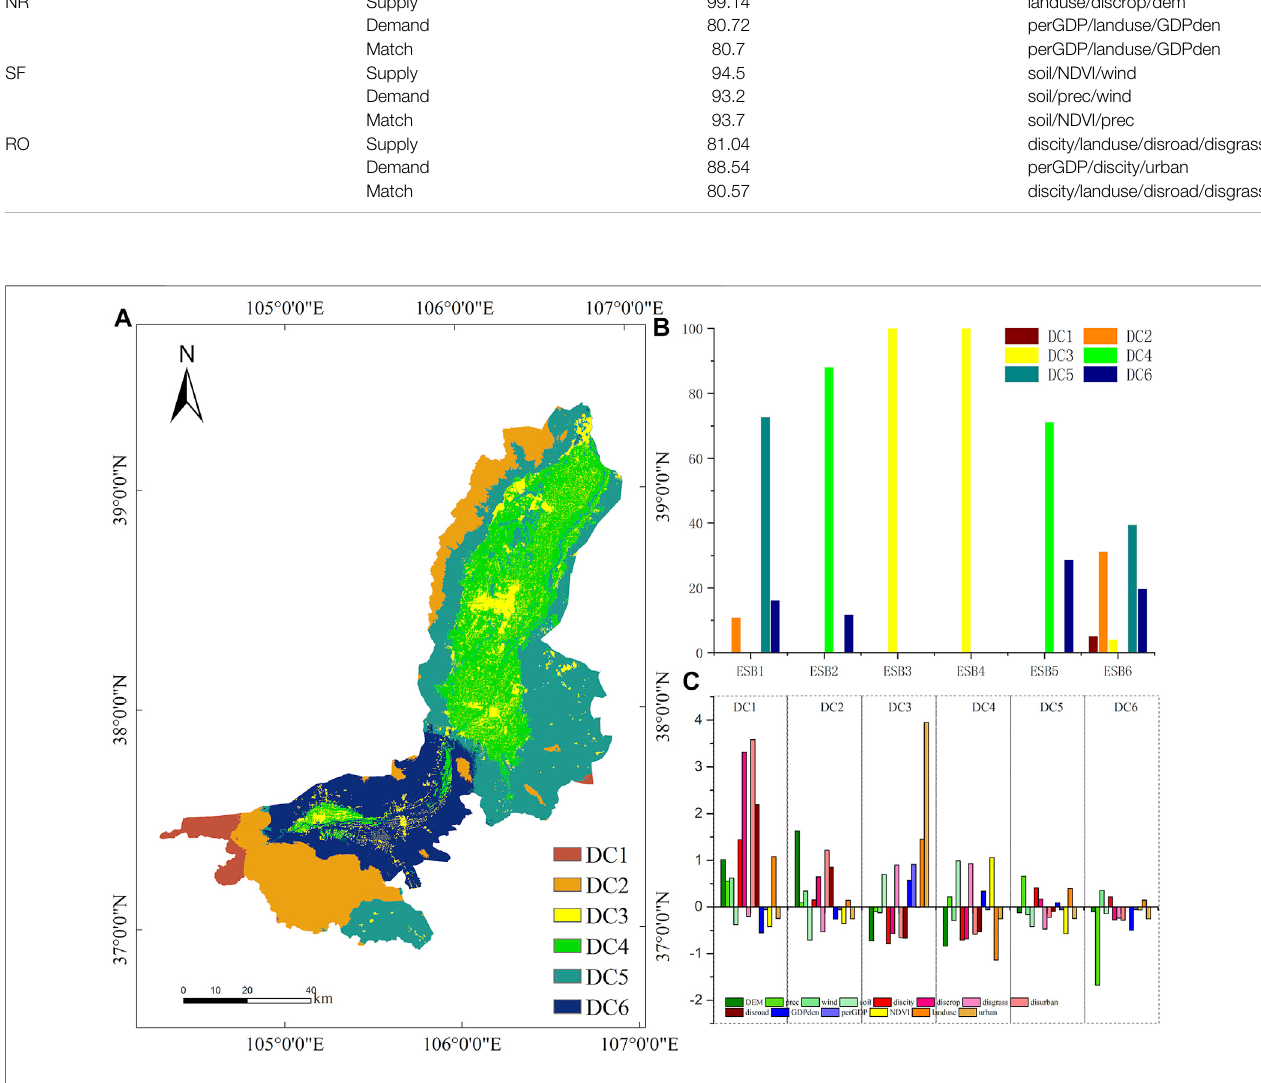
Frontiers in Environmental Science |